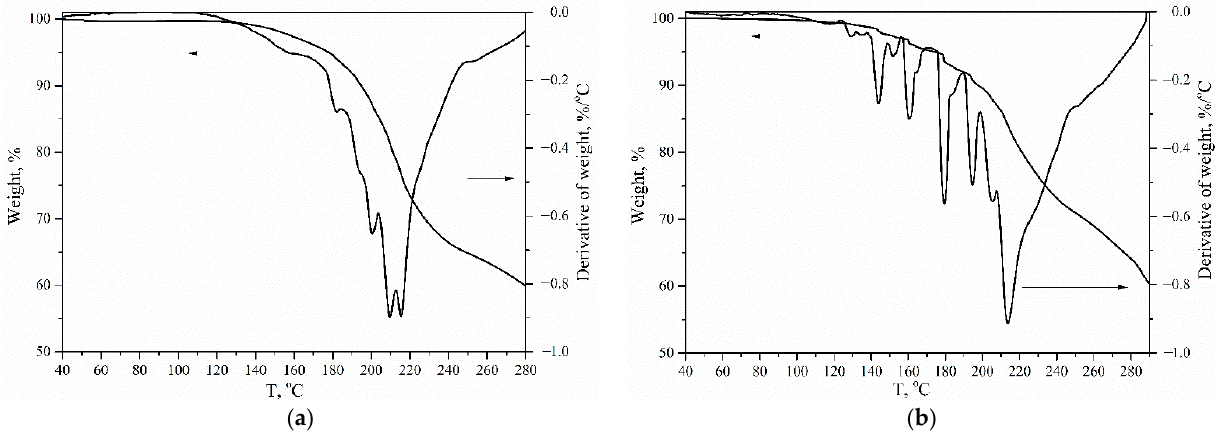
Figure 9. TGA curves of polymers obtained at [NCO] 0 /[OH] 0 = 1.5 ( a ) and [NCO] 0 /[OH] 0 = 1.88 ( b ). The measurements were performed under a nitrogen atmosphere ,with a heating rate of 2 °C/min.